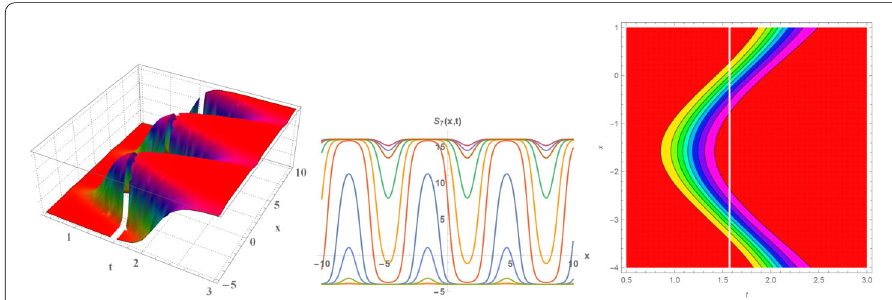
Figure 1 Numerical simulations of Eq. (14) in three different types [ a 0 = 2, a 2 = 1, c = –3, δ = –1, μ = 3, σ = 5, (cid:5) =